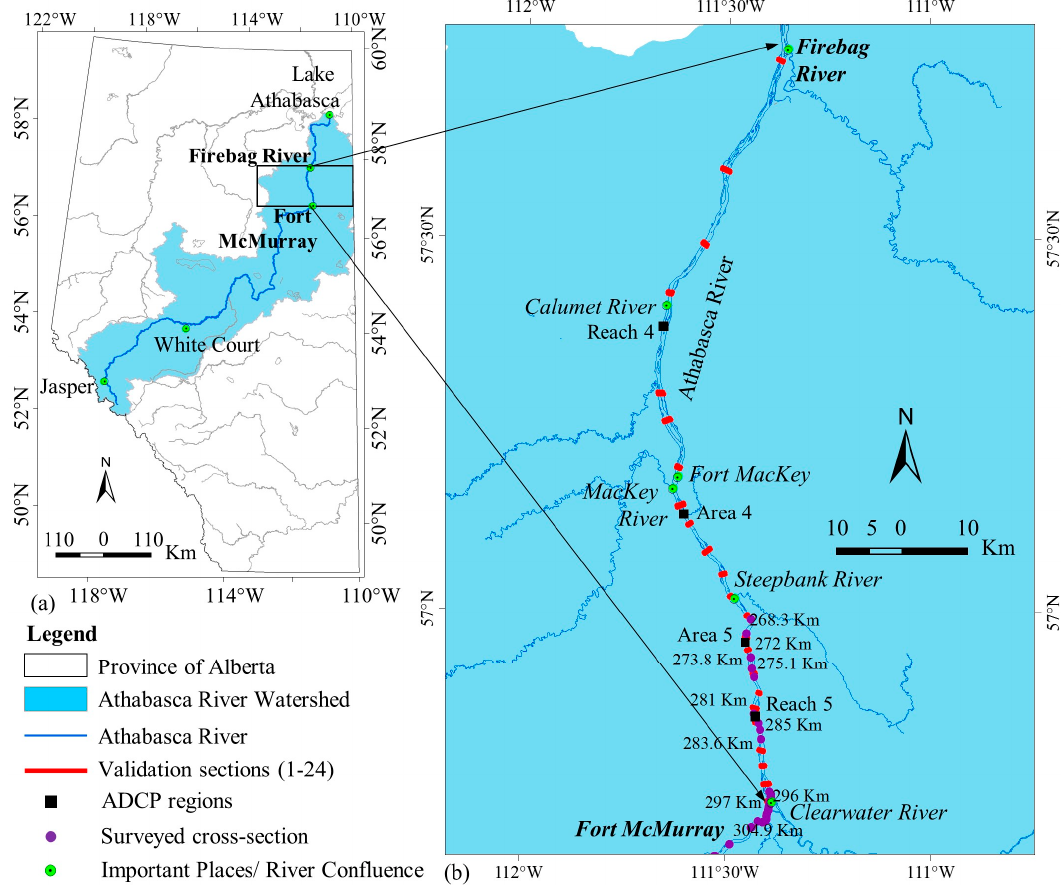
Figure 1. ( a ) Location of the Athabasca River watershed within the Province of Alberta; and ( b ) extent of the study area within the watershed.